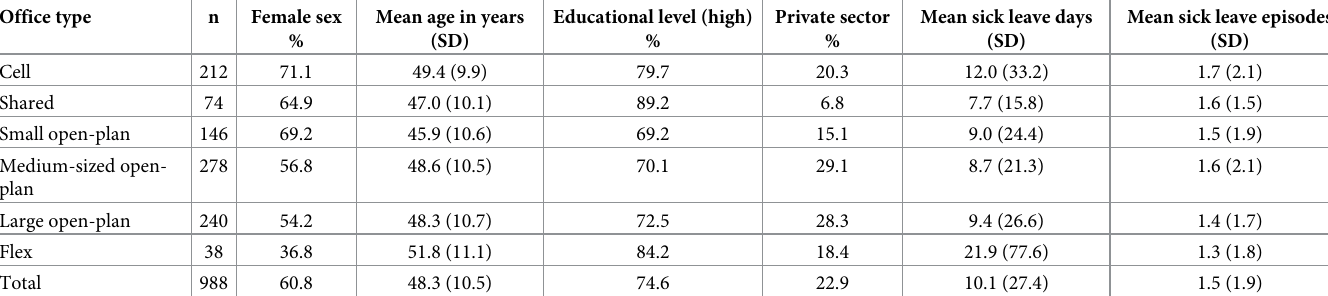
Table 2. Description of the respondents in the employer records of sickness absence sample (n = 988).